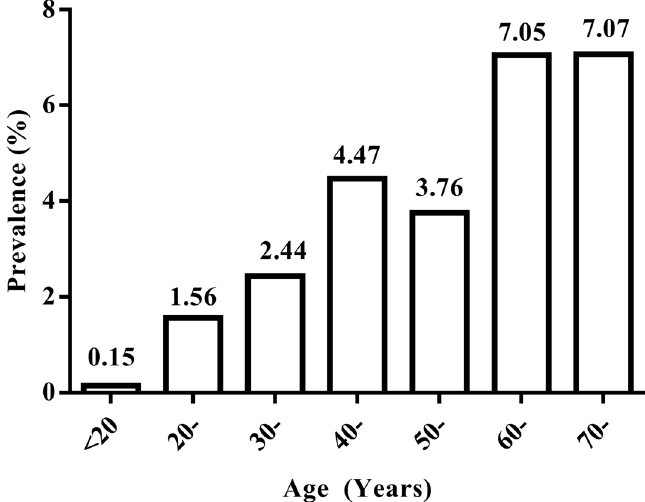
Figure 3. Prevalence of echinococcosis by age distribution in Xiaonangou township in 2011.